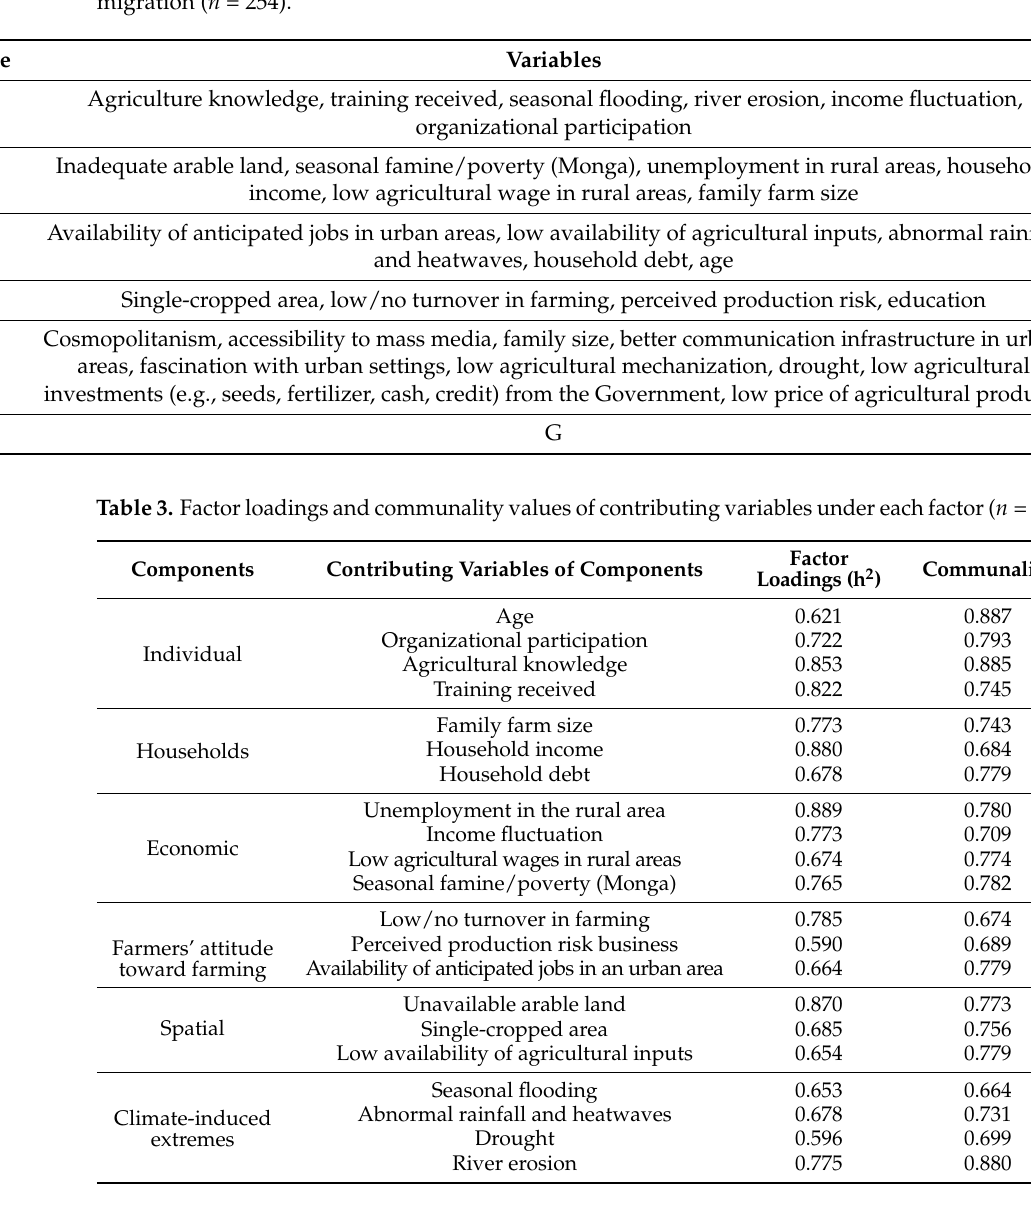
Table 2. Relatively important variables (based on the Q-methodology) influencing farmers’ internal migration ( n = 254).